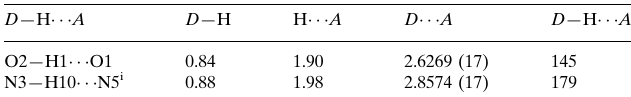
Hydrogen-bond geometry (A˚ , (cid:1)